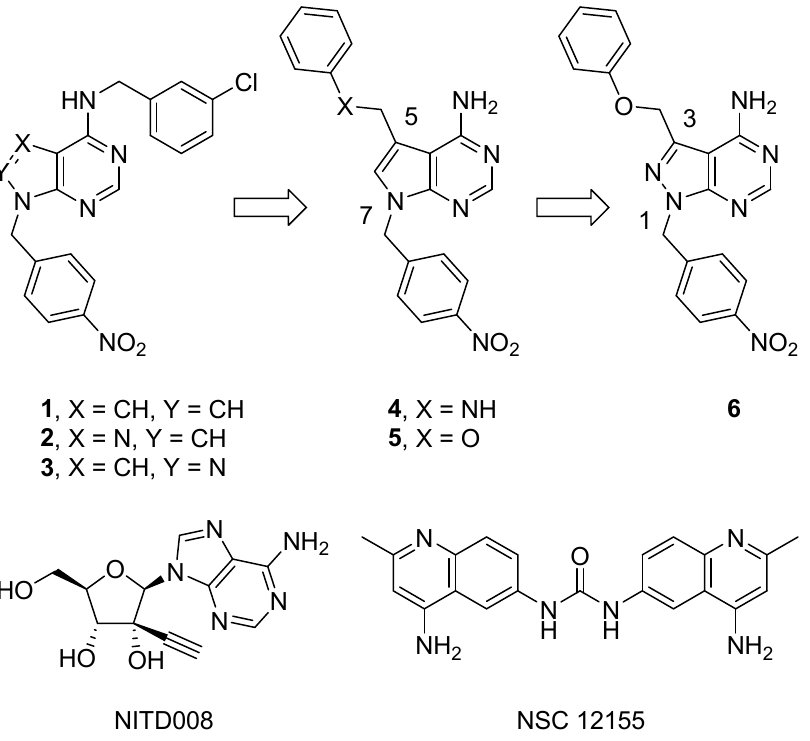
Figure 1. Selected known ZIKV inhibitors.